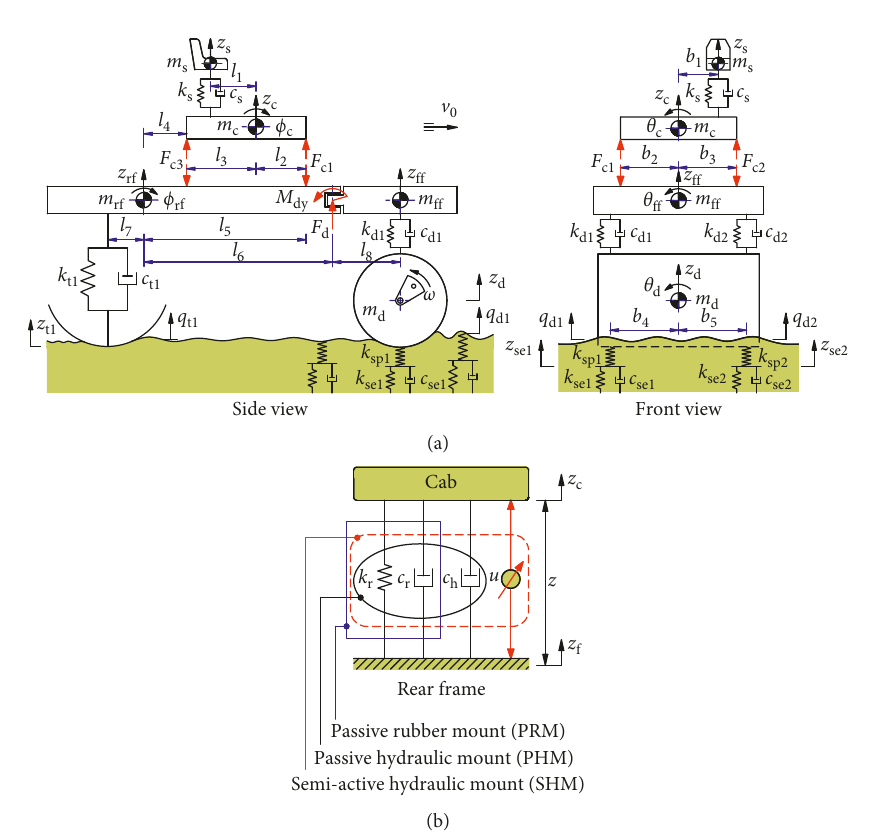
Figure 2: Lumped parameter model of the vibratory roller and different cab’s isolation mounts. (a) Vibratory roller dynamic model. (b) Cab’s isolation mount